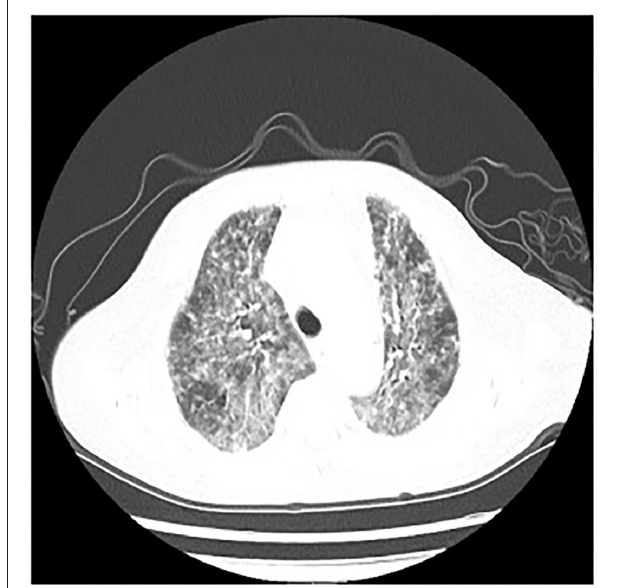
FIGURE 3 | P. jirovecii appearances on Chest CT scan in patient 2 as multiple patchy and flocculent high-density shadows in both lungs.